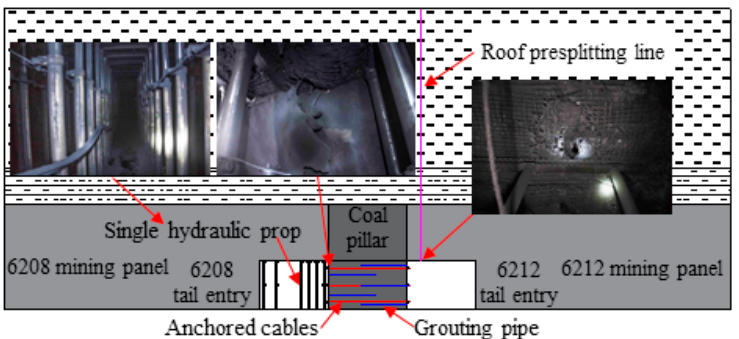
Figure 7. Roadway deformation control strategy for the small coal pillar retaining roadway.